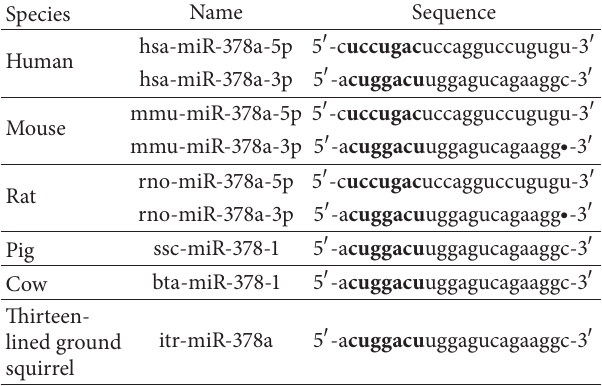
Table 2: miR-378a is highly conserved between species. Source: miRBase, version 21, September 2015 [28]. The seed sequence (defined as nucleotides 2–8 from the miRNA 5 󸀠 -end of the mature miRNA) is in bold